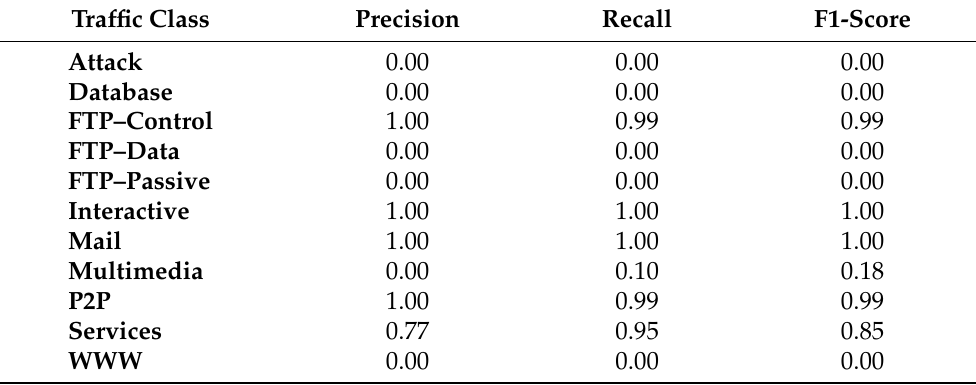
Table 7. Precision, recall, and F1-score per class for conventional port-based